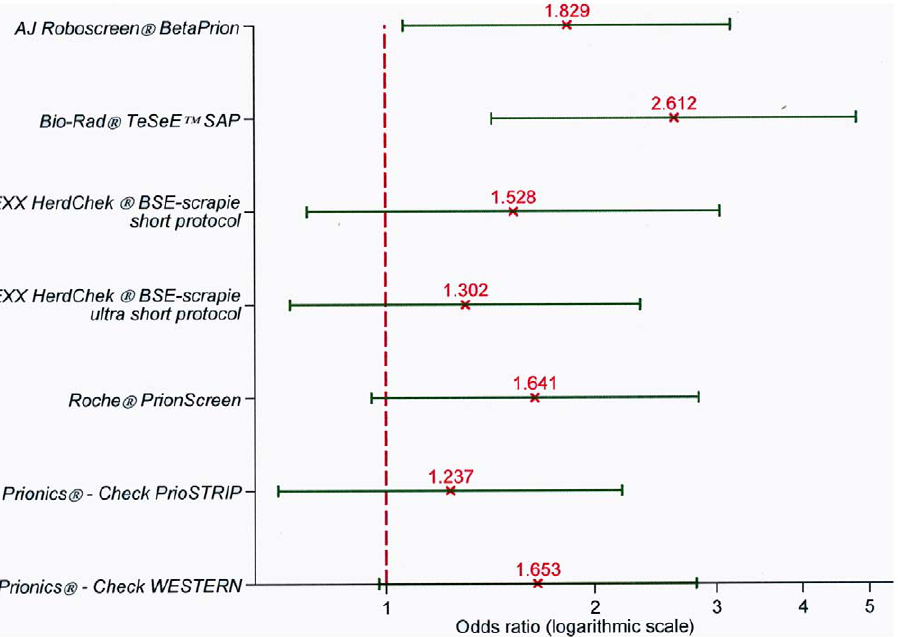
Figure 2. Comparison of test performance under the manufacturer’s dilution protocol versus the 50% w/v protocol. The vertical axis reports the different rapid tests challenged. The horizontal axis reflects the odds ratio magnitude.